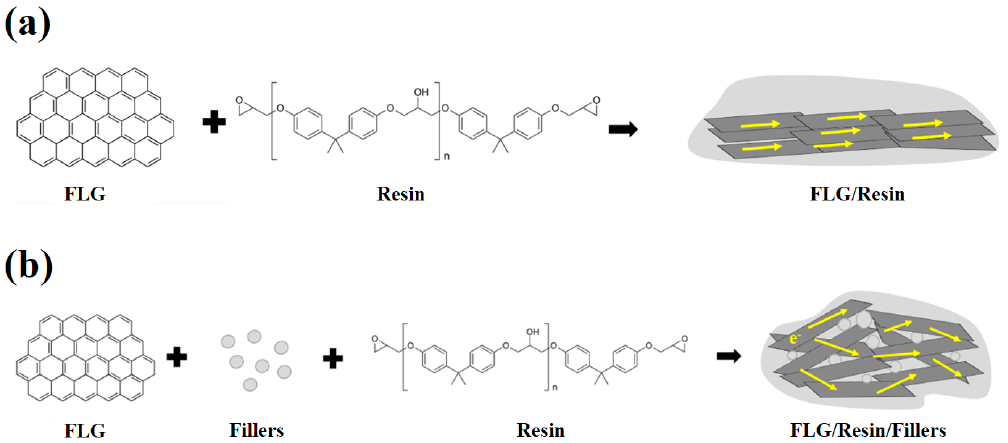
Figure 9. The before and after schematic diagram of the filler dispersion state. ( a ) Graphene composite with no filler, and ( b ) graphene composite with nano fillers.